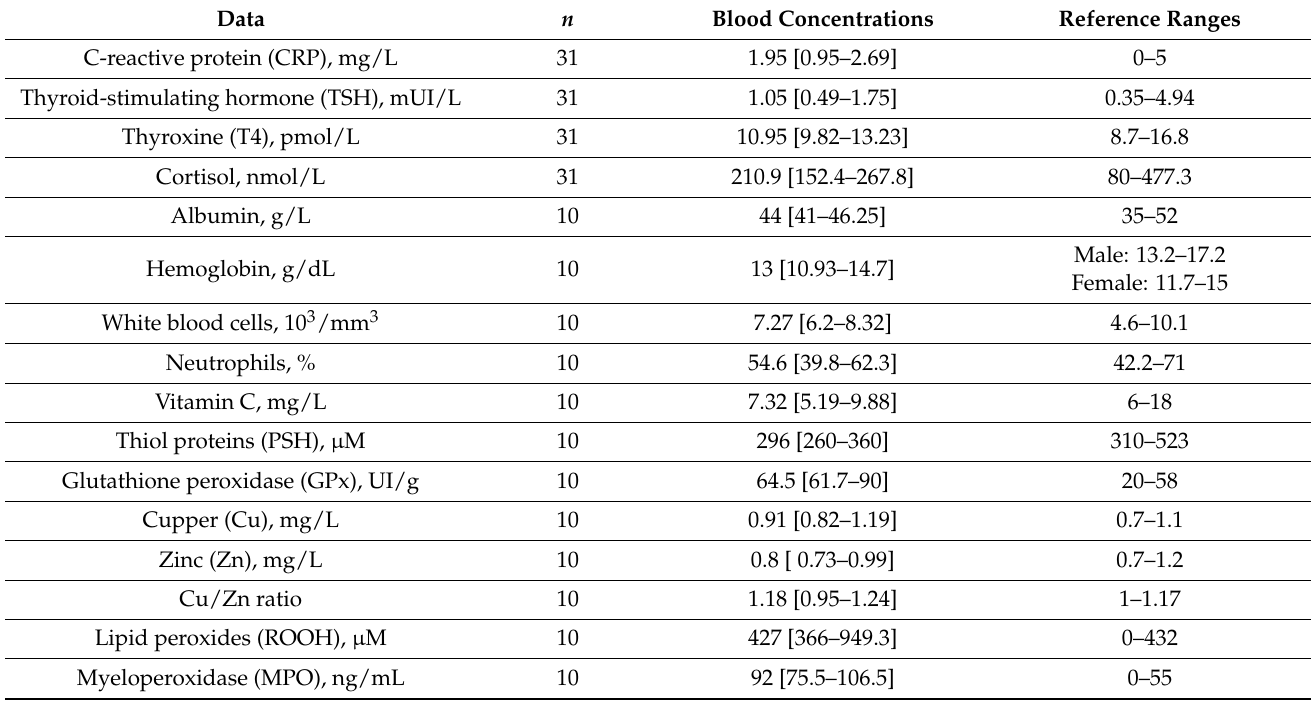
Table 4. Biological parameters in the ICU